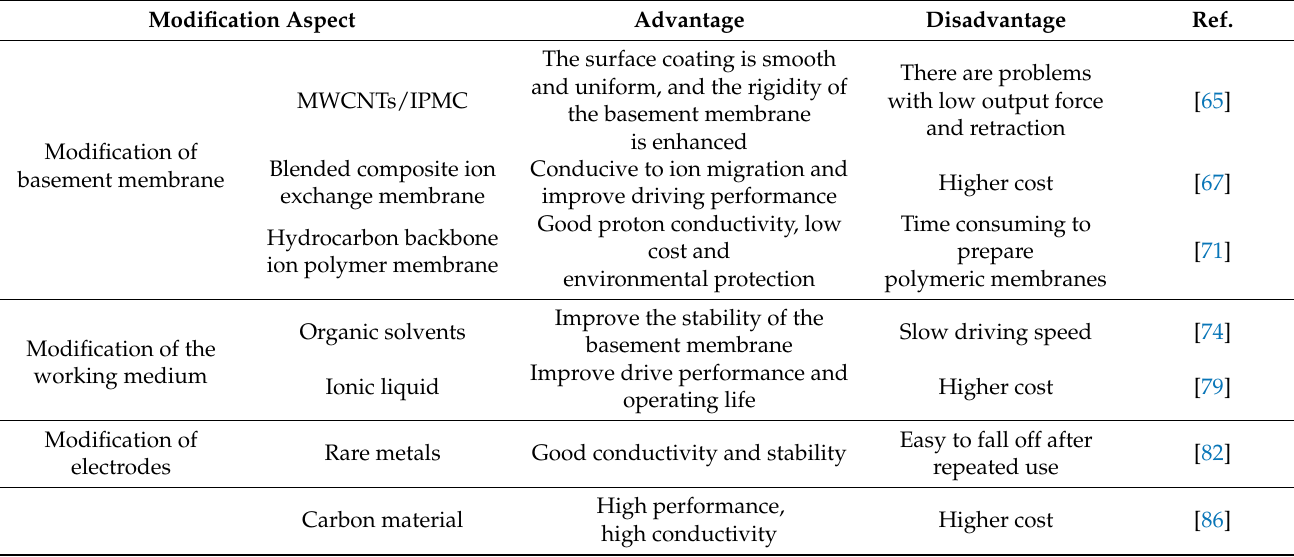
Table 4. Study on modification of